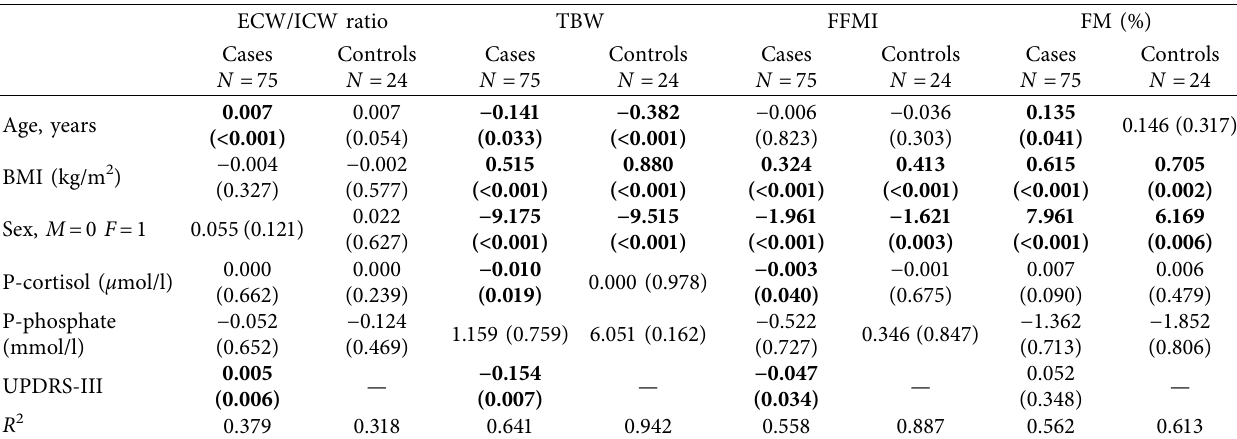
Table 5: Multiple linear regression models, B -value, and P value in patients ( N � 75) and controls ( N � 24) for ECW/ICW ratio, TBW (ECW +ICW, l), FFMI, and FM (%). Interaction between cortisol and phosphate is excluded (not significant). ECW/ICW ratio TBW FFMI